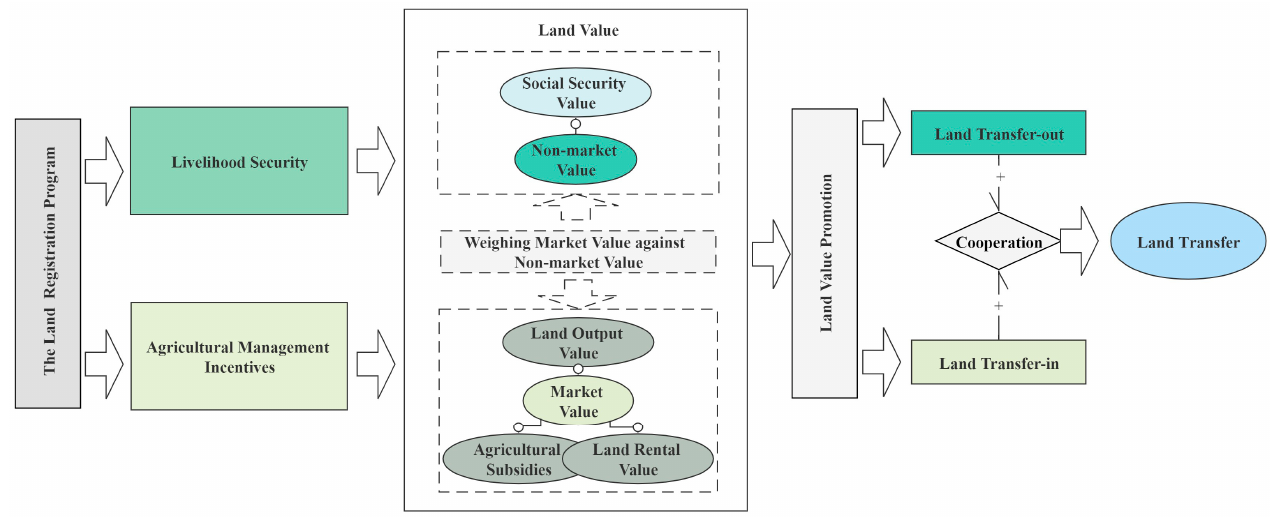
Figure 3. Theoretical analysis of the land registration program, behavioral disciplines, and land transfer.